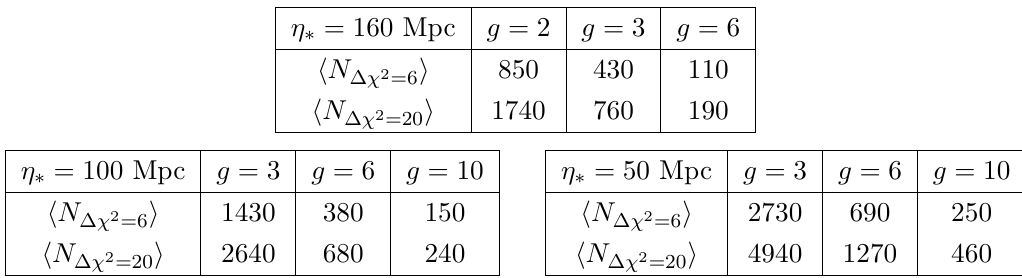
i ( h N i ) in the sky for a ∆ χ 2 = 6 ( ∆ χ 2 = 20 ) ∆ χ 2 =6 ∆ χ 2 =20 distributions. ‘